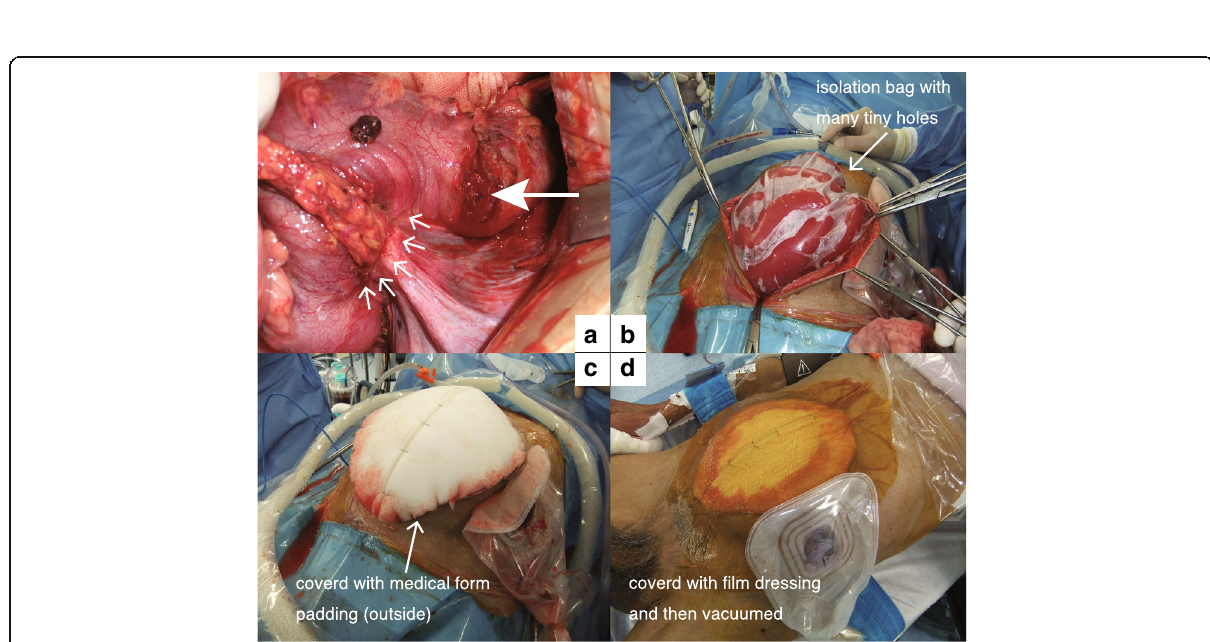
Fig. 2 Findings at the primary emergency operation. a Primary tumor invasion of the retroperitoneum (arrow), with a perforated hole (large arrow). b – d Conventional NPWT was